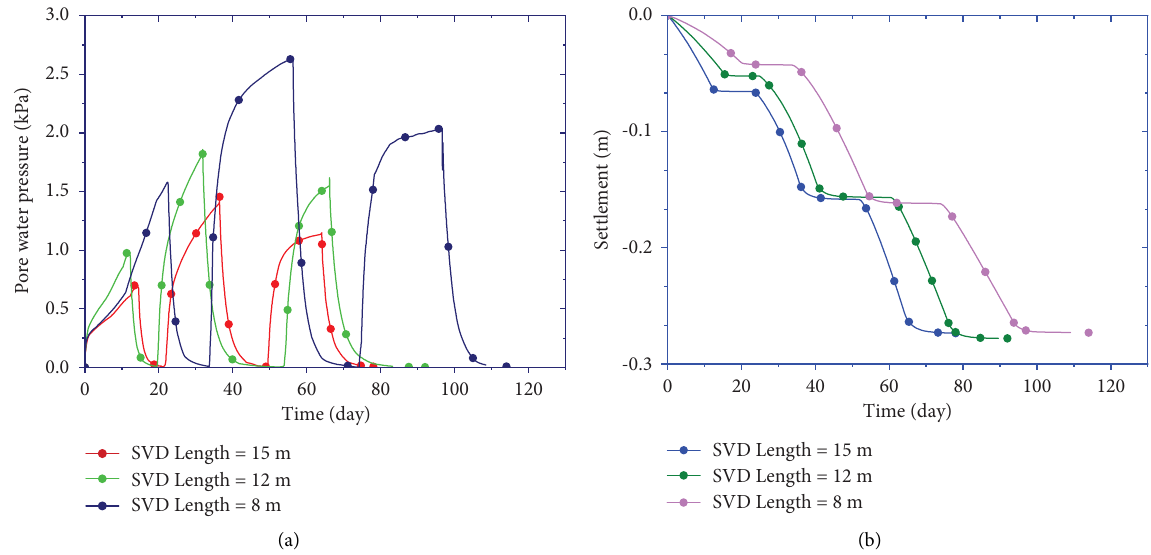
Figure 11: (a) Te efect of SVD length on pore water pressure (for D � 0.6m and S � 1.5m). (b) Te efect of SVD length on settlement (for D � 0.6m and S � 1.5